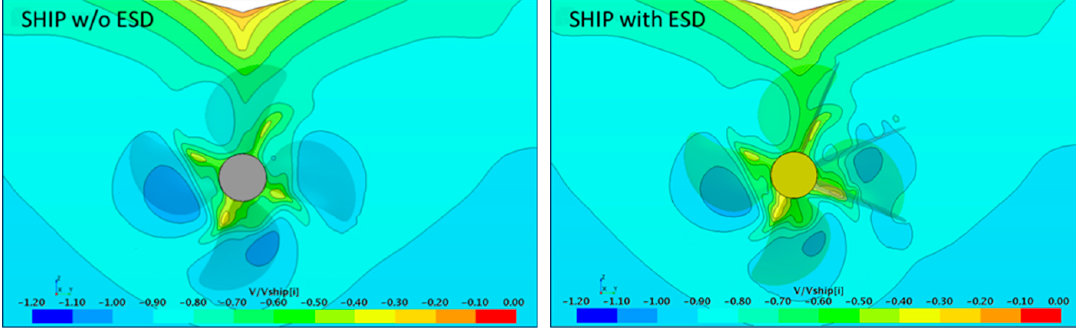
Table 6. Averaged magnitudes of kinetic energy on the sections downstream of the propeller (“Sect 2”) and downstream of the rudder (“Sect 3”). Full scale, Vs = 14 kn.